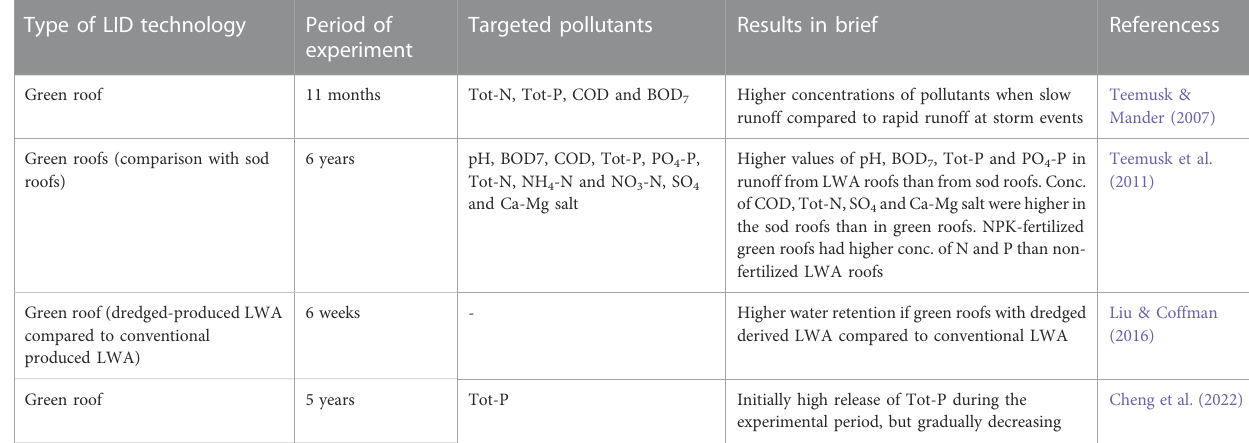
TABLE 3 Low Impact Development facilities including lightweight aggregates (LWA) as fi lter media.